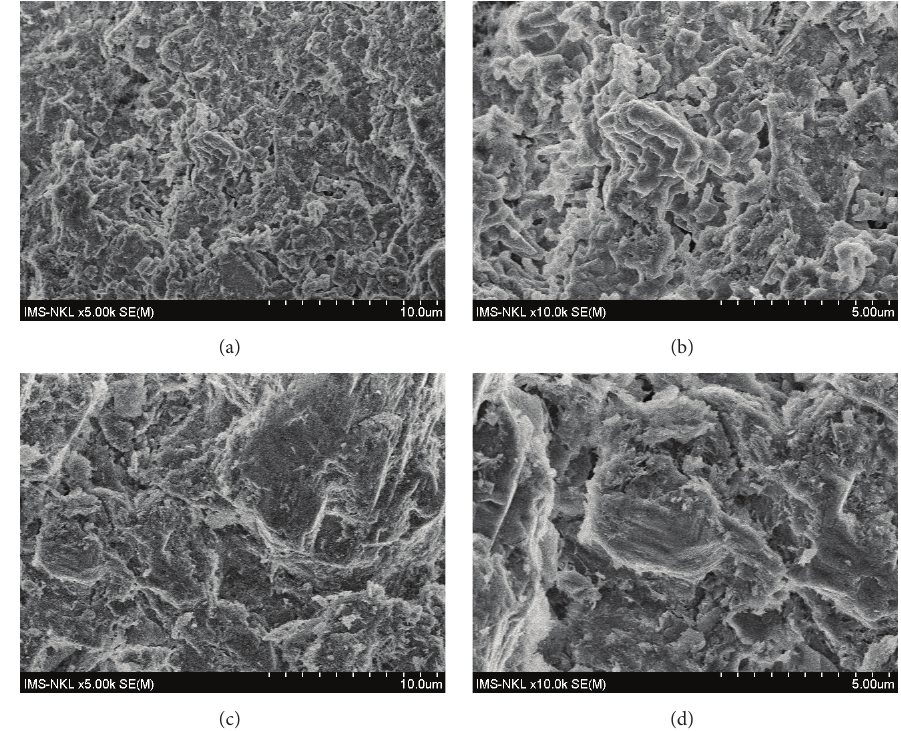
Figure 10: FESEM images of cement mortars: ((a) and (b)) before EICI treatment; ((c) and (d)) after 4 weeks of EICI treatment. Magnification for (a) to (d): at 5000x (on the left) and at 10000x (on the right), for each sample, to illustrate typical microstructure.